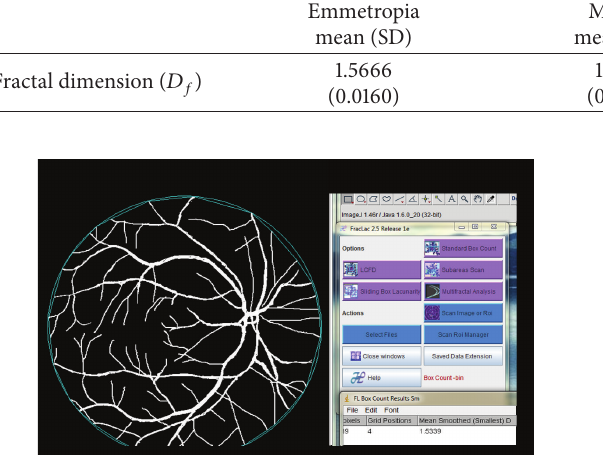
Figure 1: Measurement of fractal dimension ( 𝐷 𝑓 ) using ImageJ.